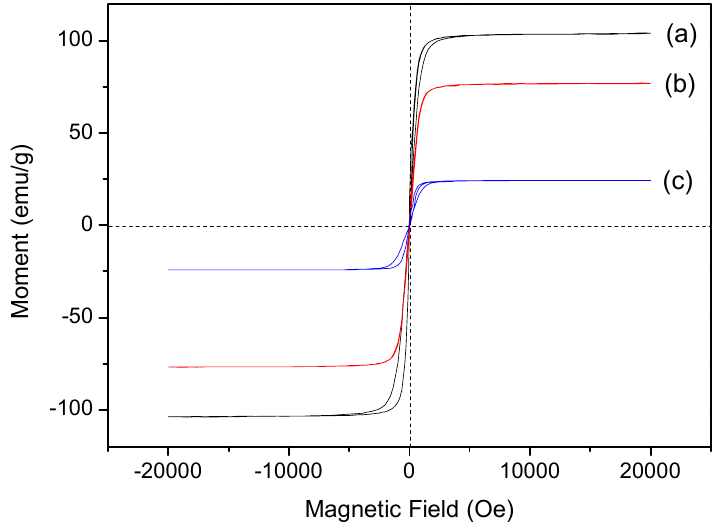
Figure 4. Room temperature magnetization curves of (a) Fe 3 O 4 nanoparticles, (b) Fe 3 O 4 /SiO 2 core-shell composite nanospheres, and (c) Fe 3 O 4 /SiO 2 /PPy core-shell composite nanospheres.